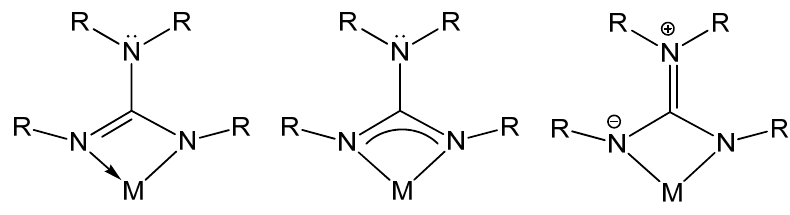
Figure 2. Electronic delocalization in guanidinato ligands.